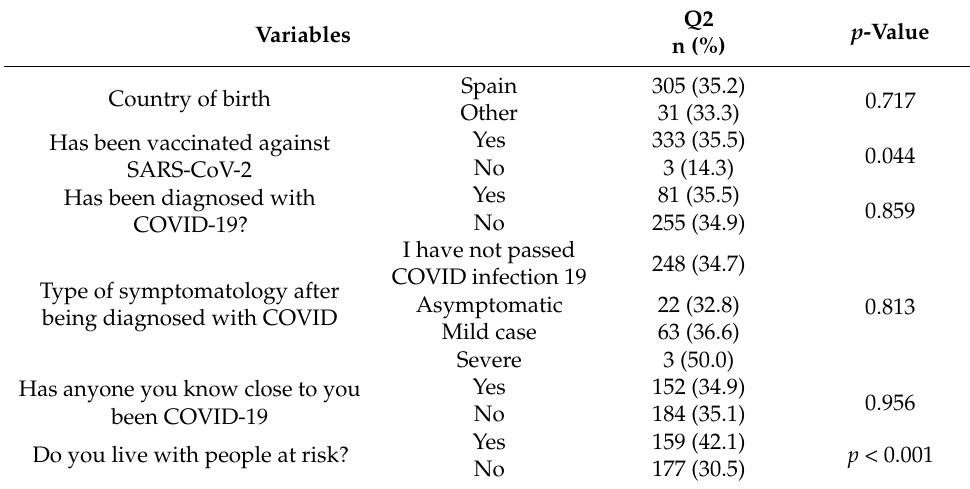
Table 3. Influenza vaccine coverage according to factors related to COVID infection (in students participating in Q2).